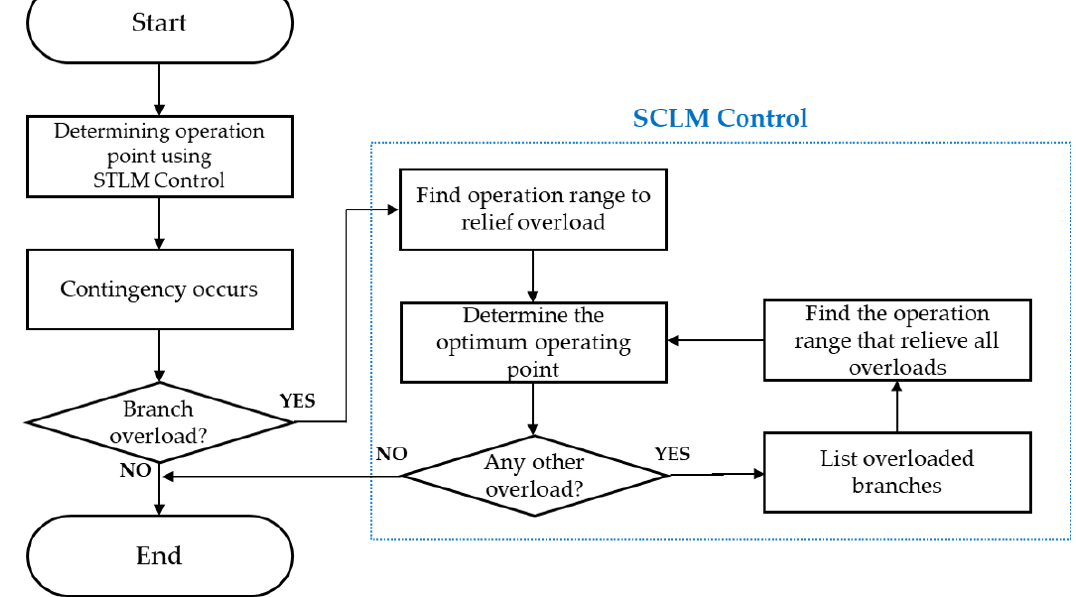
Figure 5. Algorithm of the security-constrained loss minimization (SCLM) control.